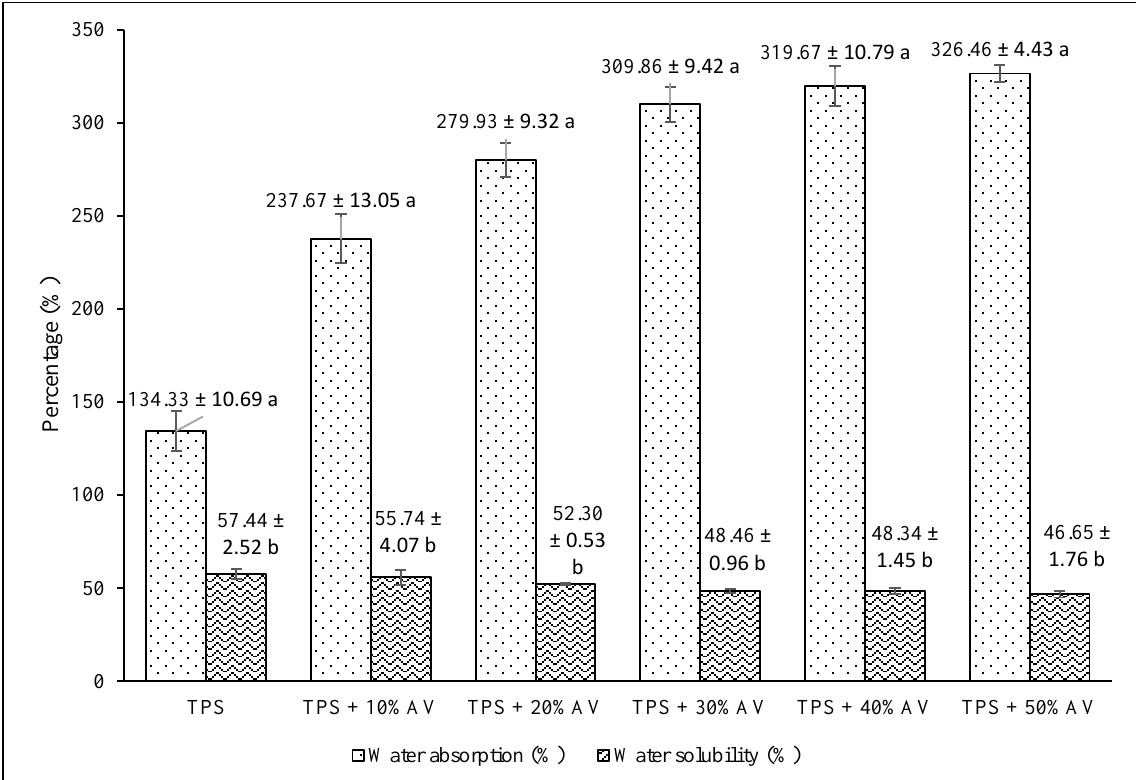
Figure 2. The percentages of water absorption and water solubility of TPS film with different AV gel concentrations. Different letters indicate significant differences between the values at the level of significance, p < 0.0083 (Bonferroni adjustment), one-way ANOVA, post-hoc t -test. Values are mean ± SD (standard deviation).